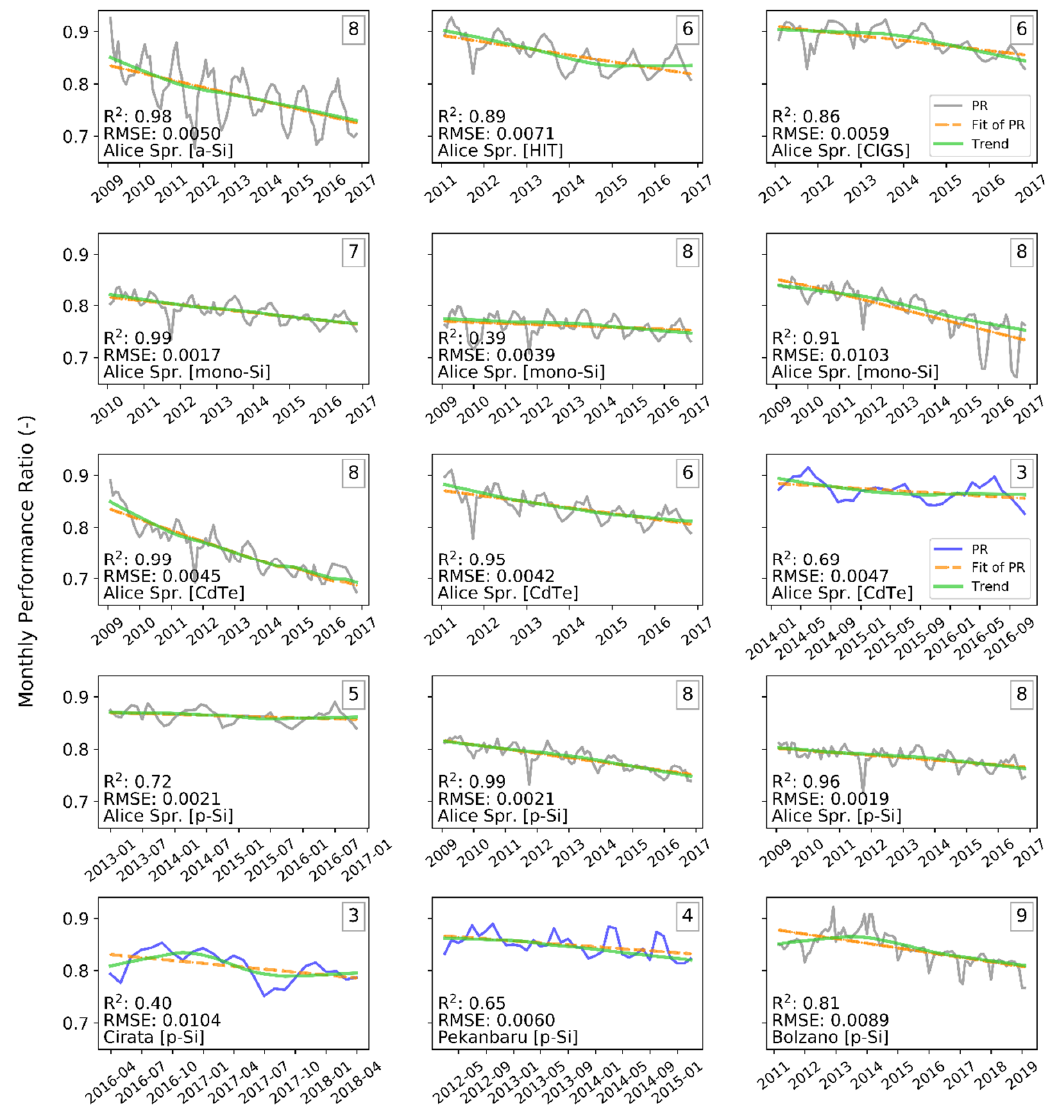
Figure 8. Annual-averaged monthly temperature-corrected performance ratios, PR ann. , of the PV systems (grey or blue lines), their linear fit (dashed orange line), and trend components (green line) over the monitoring period. Numbers at the top right of the charts indicate the lengths of the data in years.